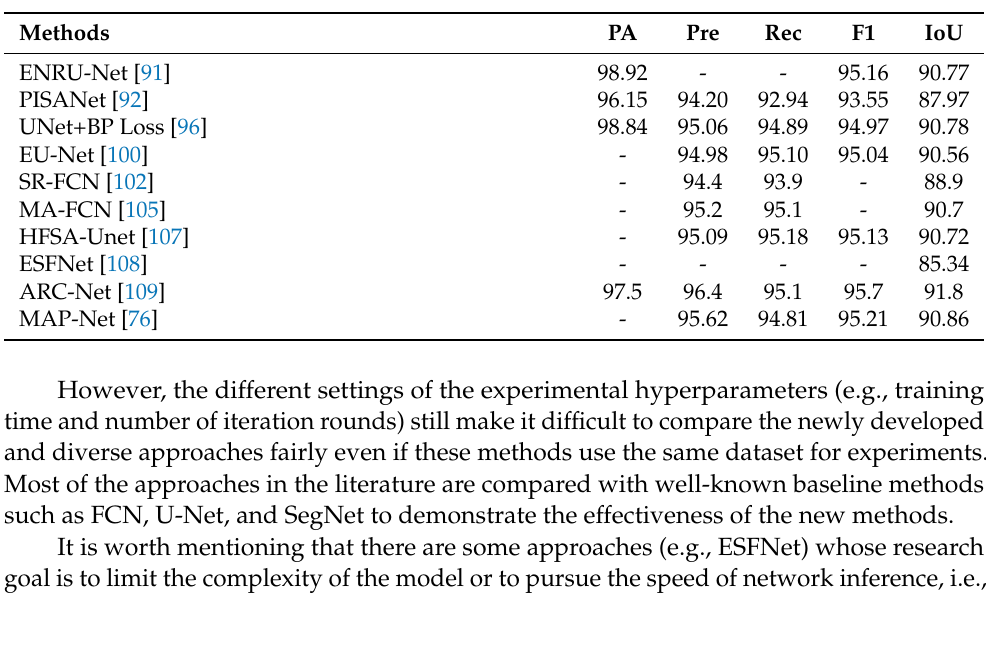
Table 4. Results on WHU aerial building dataset